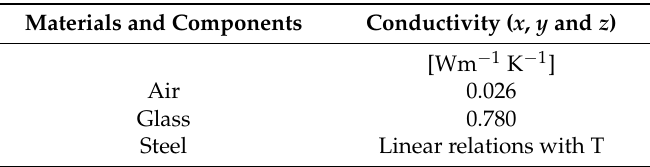
Table 2. Conductivity of materials used in the